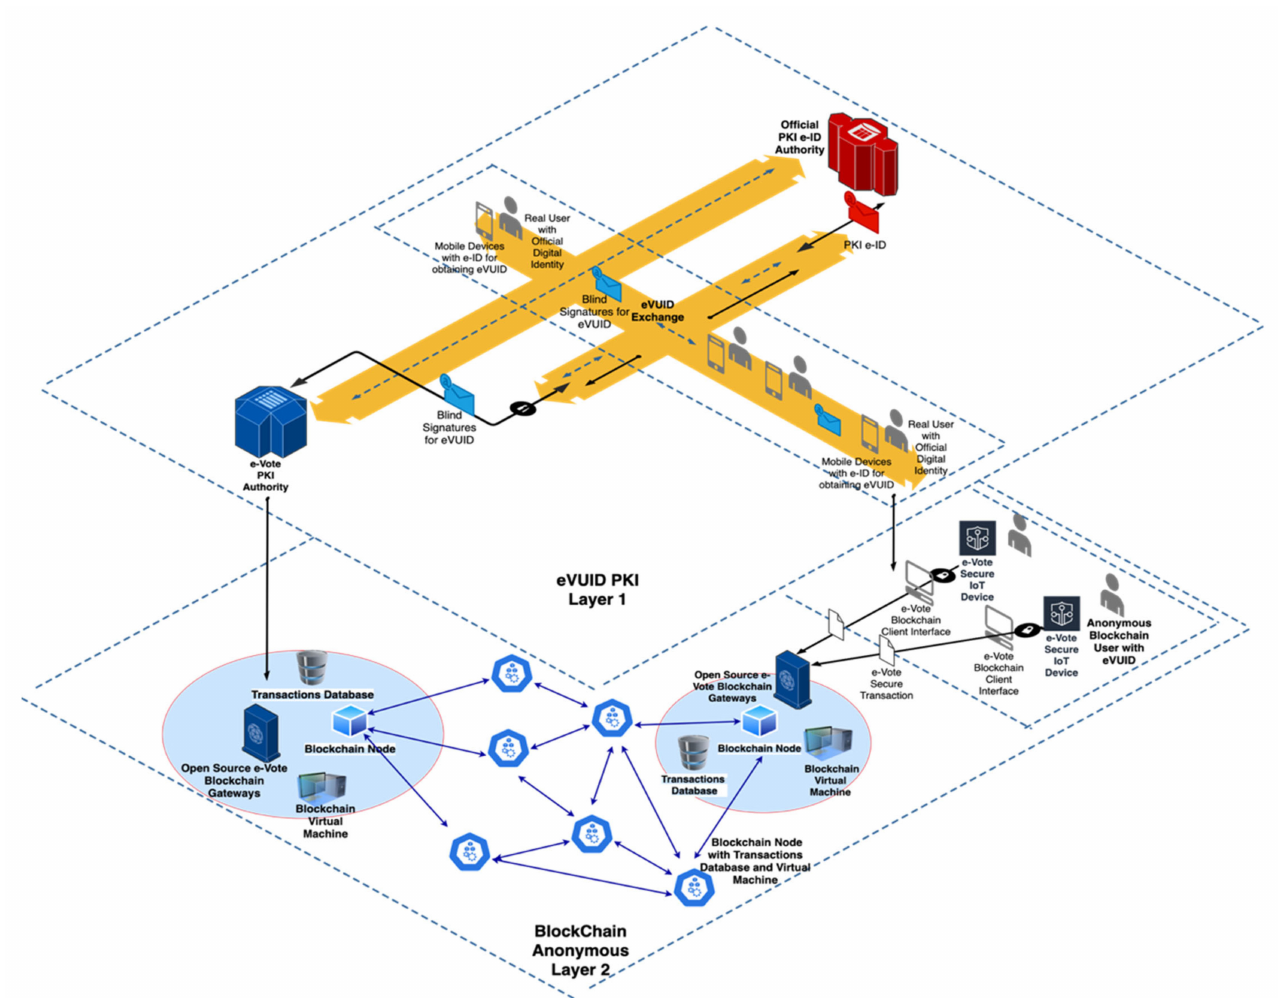
Figure 2. Architecture of the e-VoteD-App Solution System—2